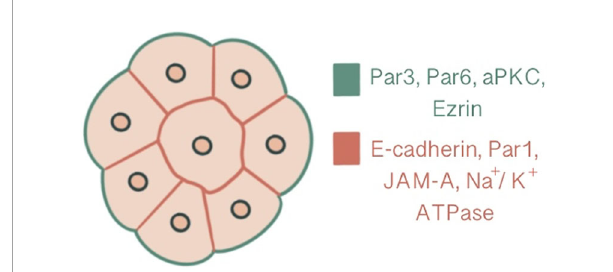
FIGURE 2 Polarization demonstrated at a 16-cell stage embryo, central slice. Ezrin, Par6, Par3, aPKC are present at the apical domain which is enriched with actin, whereas Par-1, JAM-A, Na/K ATPase and E- cadherin are localized at the basolateral